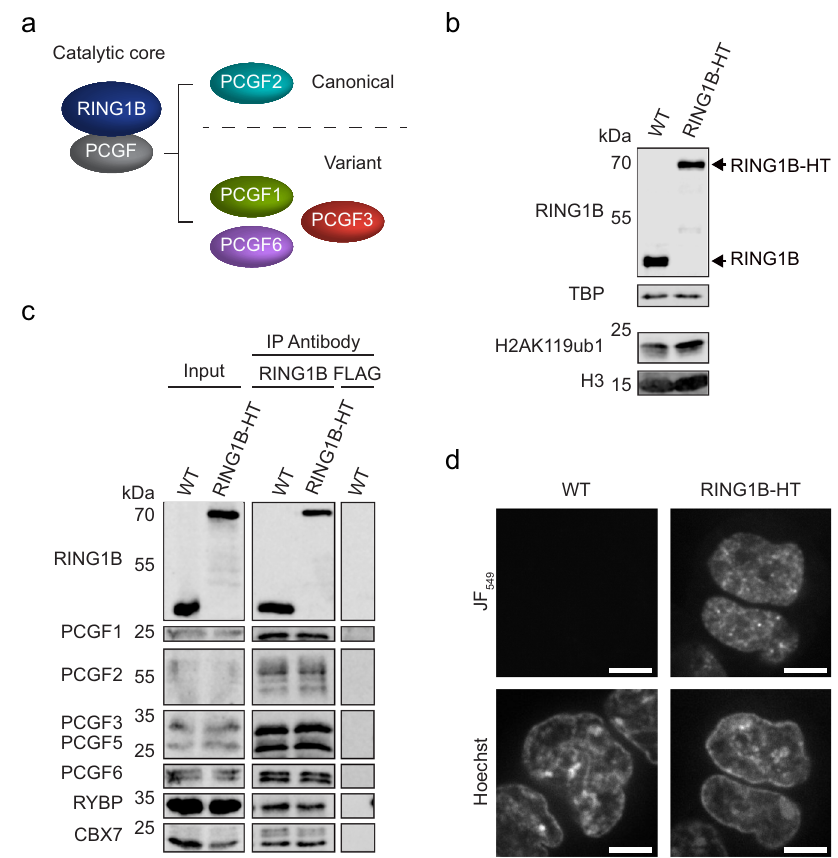
Fig. 1 Endogenous Halo-tagging of RING1B enables live-cell imaging of PRC1. a A schematic illustrating the general organisation of PRC1 complexes. b Western blots for RING1B (upper panels) and H2AK119ub1 (lower panels) comparing wild type (WT) and homozygous RING1B-HaloTag (RING1B-HT) cell lines. The expected size shift on addition of the HaloTag and linker is 35 kDa. TBP and H3 were used as loading controls. n = 1 biological replicate. Source data are provided as a Source Data fi le. c Immunoprecipitation (IP) of RING1B from WT or RING1B-HT ESCs followed by western blotting for PRC1 subunits to con fi rm normal complex formation. For WT ESCs, a control IP was performed using a FLAG antibody. n = 1 biological replicate. Source data are provided as a Source Data fi le. d Representative single Z-slice of untagged (WT) and RING1B-HT ESCs labelled with JF 549 and Hoechst. Scale bar = 5 μ m. Imaging was performed in n = 2 biological